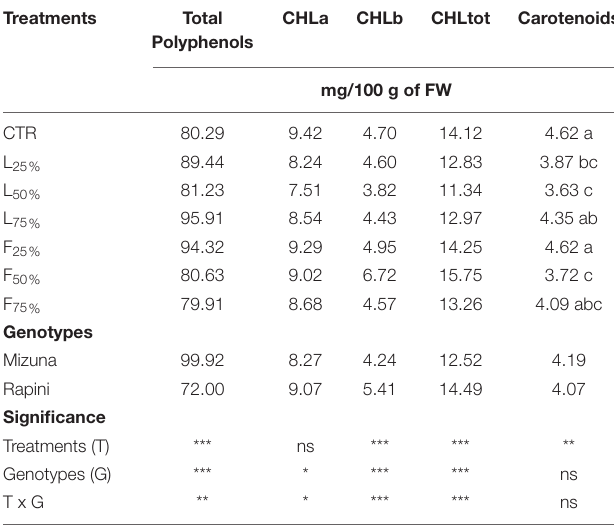
TABLE 9 | Total polyphenols, chlorophyll and carotenoids contents in Brassica rapa L. Mizuna and Rapini group microgreens, produced in greenhouse,